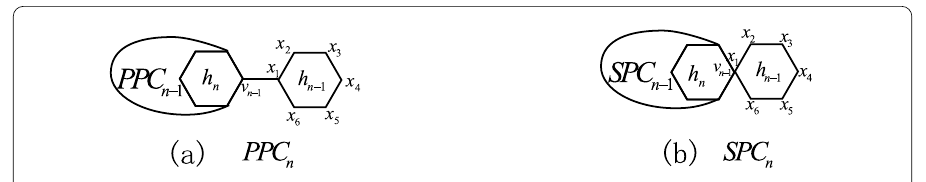
Figure 1 A polyphenyl chain PPC n and the corresponding spiro chain SPC n with n